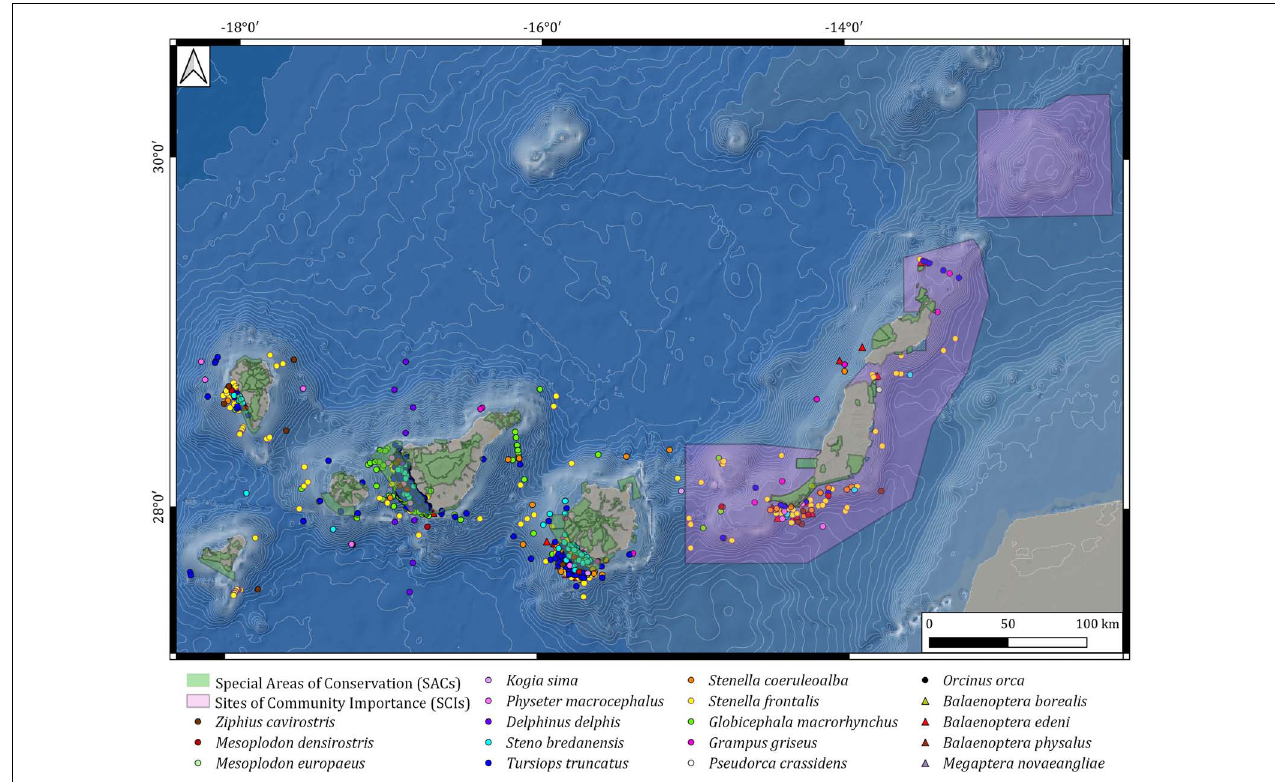
FIGURE 6 | Cetacean spatial distribution around the Canary archipelago (Odontoceti: circles; Mysticeti: triangles), including the Special Areas of Conservation (SACs; green color) and the Sites of Community Importance (SCIs; pink color).